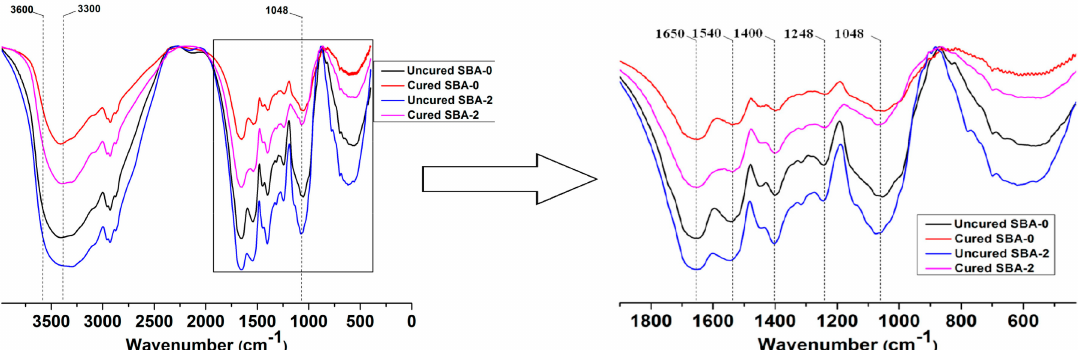
Figure 1. FTIR spectra of uncured SBA-0, cured SBA-0, uncured SBA-2 and cured SBA-2. FTIR = Fourier